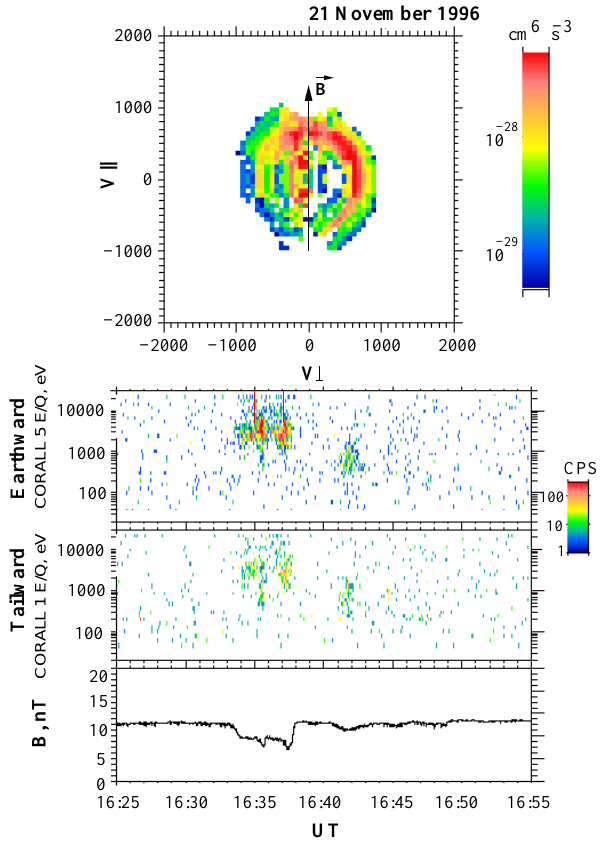
Fig. 5. An example of PS-like structure (plasma filament) observa- tion. Figure layout is the same as in Fig. 2.